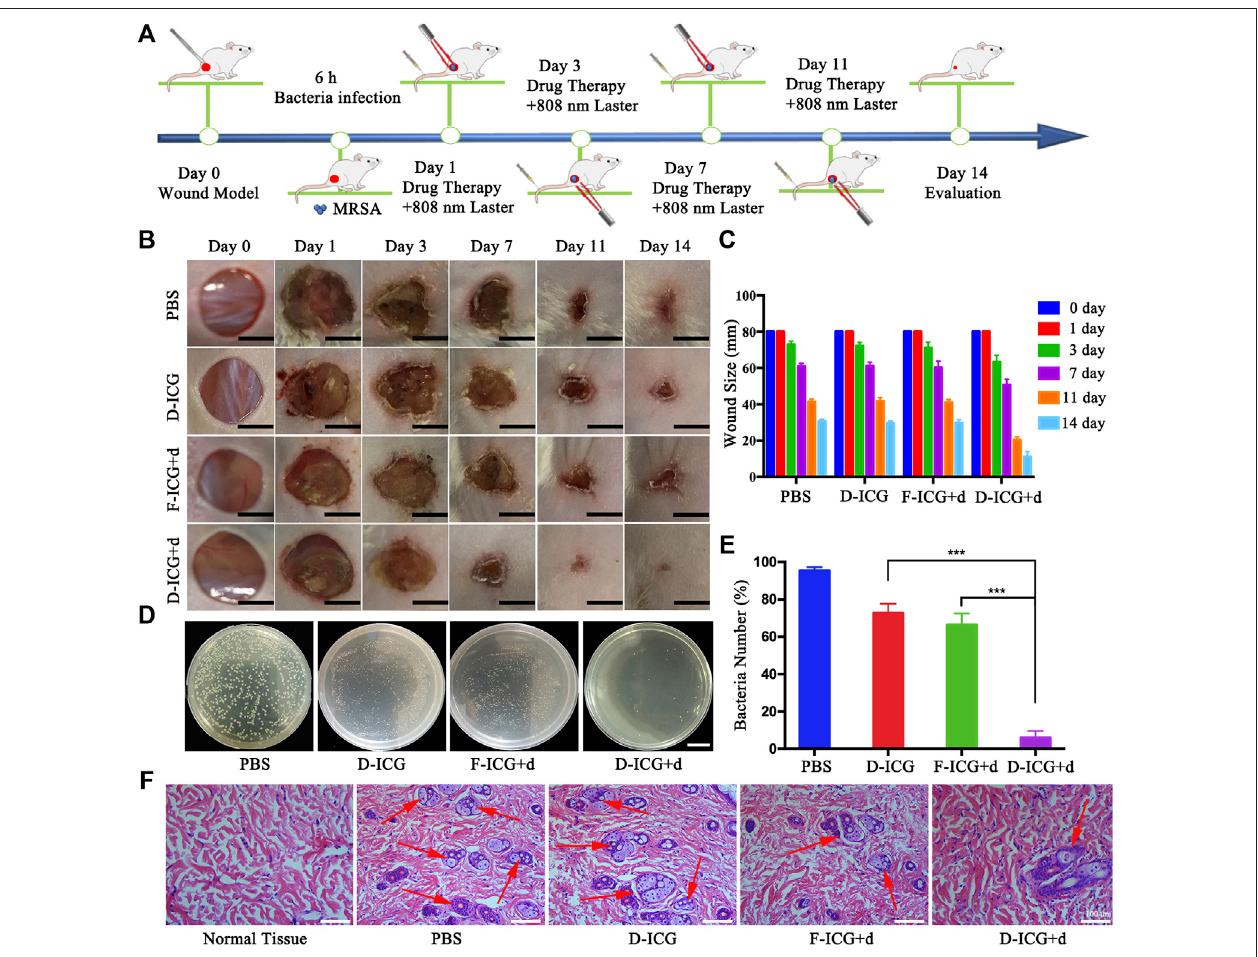
FIGURE 6 | In vivo antibacterial effect on treating subcutaneous abscess of MRSA -infected mice. (A) Schematic diagram of the cut injury and the following MRSA vaccination. (B) Changes in wounds size from day 1 to day 14, each group of mice was severally treated with PBS, D-ICG, F-ICG + d, or D-ICG + d; scale bars are 50 mm. (C) Wound size(%) ondifferentdays (1, 3,7, 11, and 14) (n=5). (D) Correspondingstatistical results ofcolony counts in wound tissue (*** p < 0.001, ** p < 0.01, * p < 0.05). (E) Number of bacteria on the wound skin tissues using the agar plate dilution. (F) Photomicrographs showing sections of wound tissues with H&E staining. In fl ammatory cells are marked by red arrows. Scale bars are 100 μ